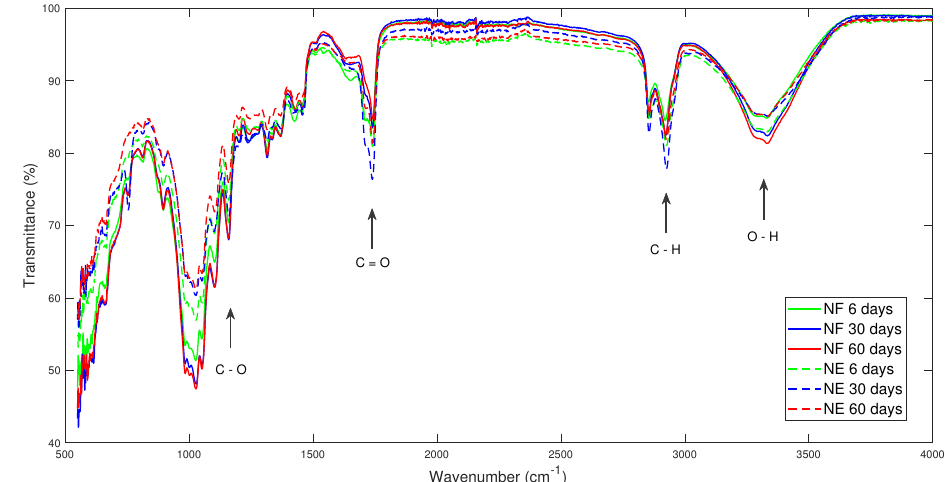
Figure 11. FTIR spectrum of cellulose impregnated with NF and NE, subjected to different aging